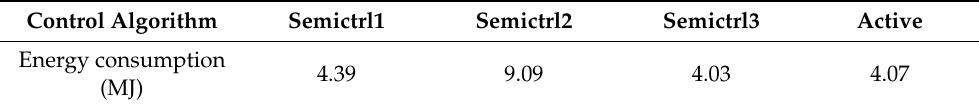
Figure 5. Time–history of energy loss of dampers under various algorithms. Table 3. Energy consumption of dampers under the action of various algorithms.